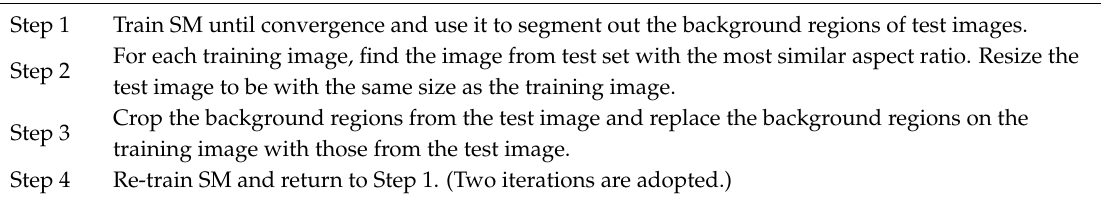
Algorithm 2 : Scheme of domain randomization